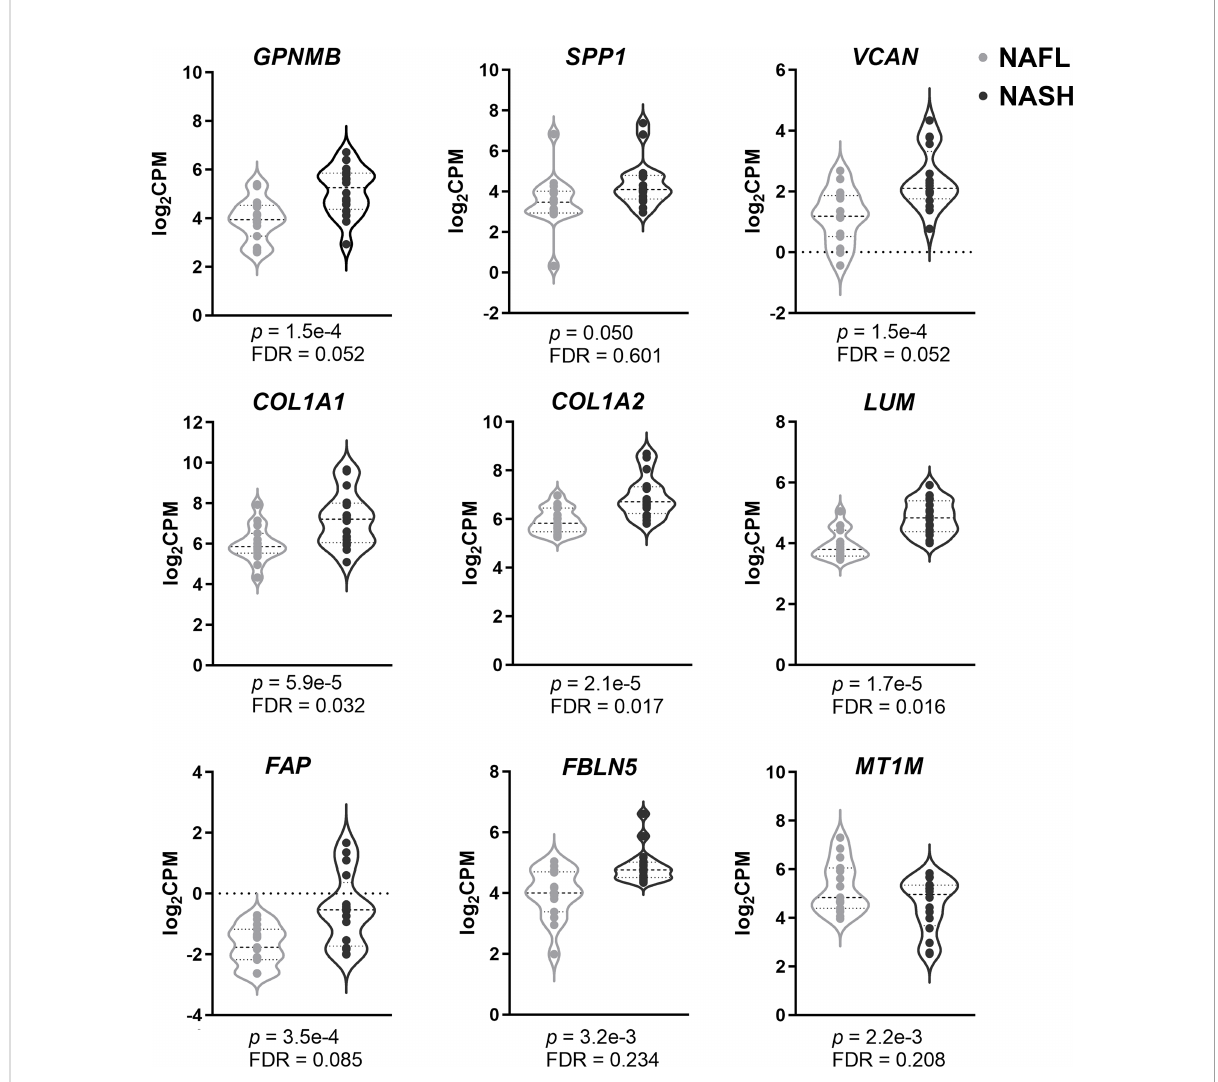
FIGURE 3 Validation of hub genes using sequencing data. Violin plots of the nine hub genes ’ expression (GPNMB, SPP1, VCAN, COL1A1, COL1A2, LUM, FAP, FBLN5, and MT1M) between NASH and NAFL. Genes with p -value <0.05 were considered to be signi fi cant. FDR, false discovery rate; CPM, counts per million; NASH, non-alcoholic steatohepatitis; NAFL, non-alcoholic fatty